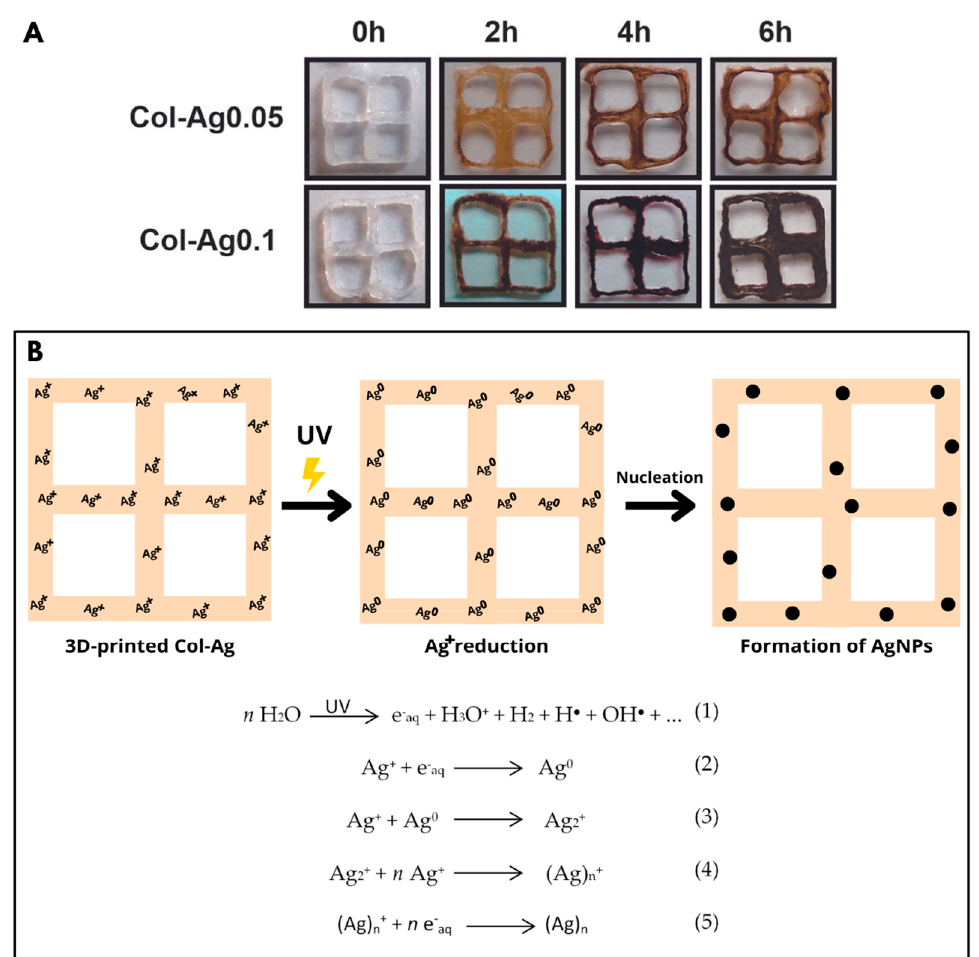
Figure 1. ( A ) Images of dry 3D-printed collagen-based scaffolds after in situ reduction of Ag by different UV irradiation intervals. Dimensions of 3D-printed collagen-based scaffolds are 6 mm × 6 mm × 2 mm. ( B ) Schematic illustration of the mechanism of in situ AgNPs formation by using the UV irradiation method.